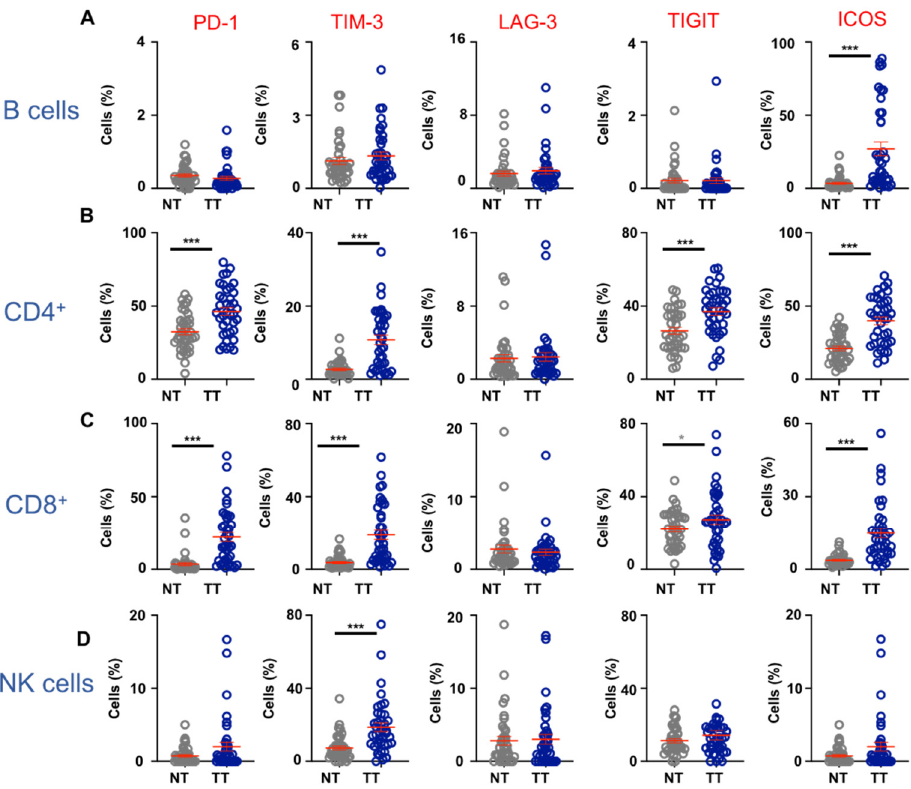
Figure 2. Immune checkpoint expression on different lymphocyte populations in the colorectal tumor microenvironment. We investigated differences in levels of immune checkpoints; PD-1, TIM-3, LAG-3, TIGIT, and ICOS-expressing B cells, CD4 + T cells, CD8 + T cells and NK cells in NT and TT of 50 CRC patients. Cumulative scatter plots show differences in levels of IC-expressing B cells ( A ), CD4 + T cells ( B ), CD8 + T cells ( C ), and NK cells ( D ) in NT and TT. The p values are represented as follows; * p < 0.05, *** p < 0.001.